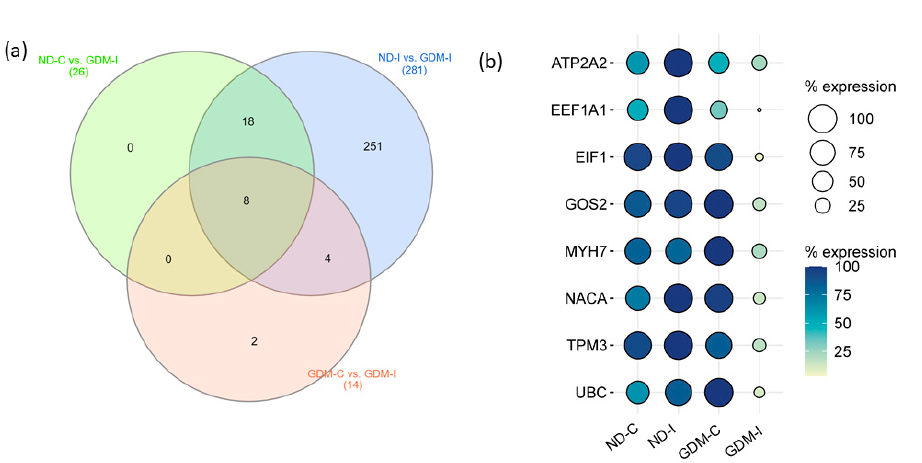
Figure 5. The profiling of differentially expressed genes (DEGs) of gestational diabetic continent women (GDM-C) in comparison with gestational diabetic and incontinent women (GDM-I). ( a ) Biological processes were identified for up- and downregulated genes. Enrichment was defined as the 10 most significant terms according to the highest scores and p -values (<0.05). ( b ) Protein–protein interaction network representing DEGs. The interaction map was generated using STRING with clusters, a high confidence of 0.7, and all criteria for linkage (co-occurrence, co-expression, experiments, neighborhood, databases, text-mining, and homology). The genes used in this network are listed in Supplemental Table S1.